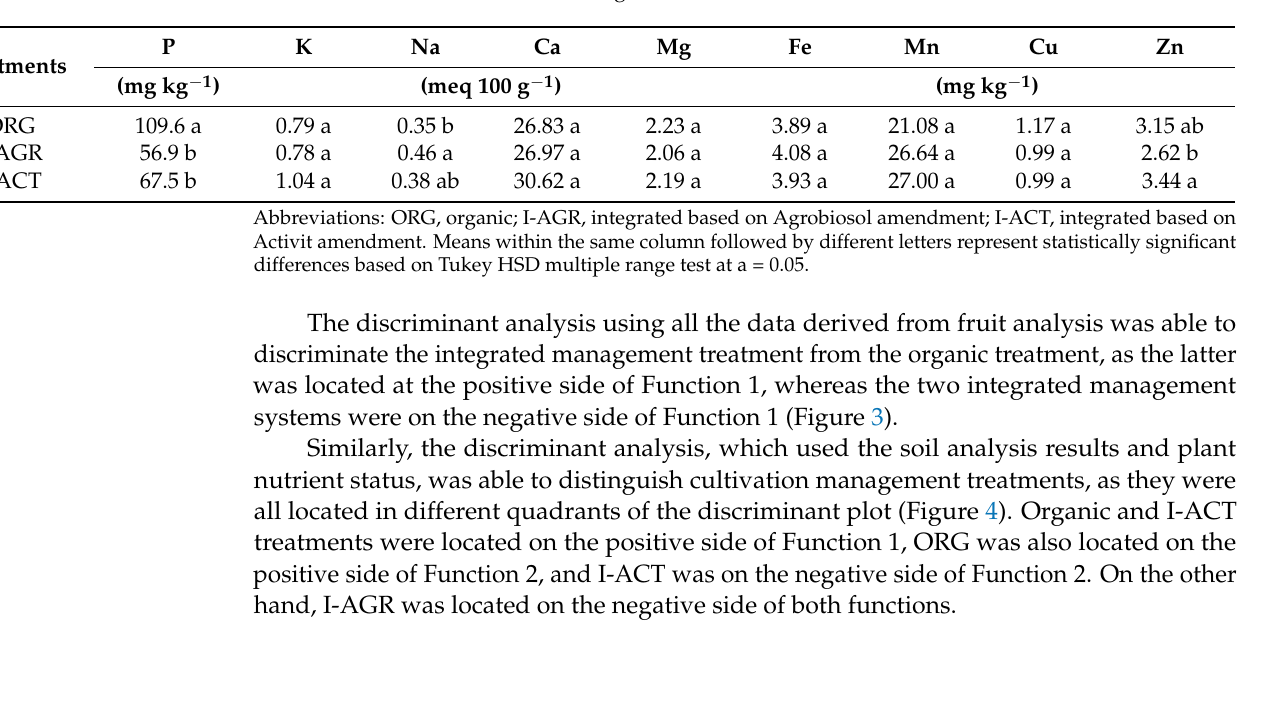
Table 10. Effects of cultivation management on soil nutrient